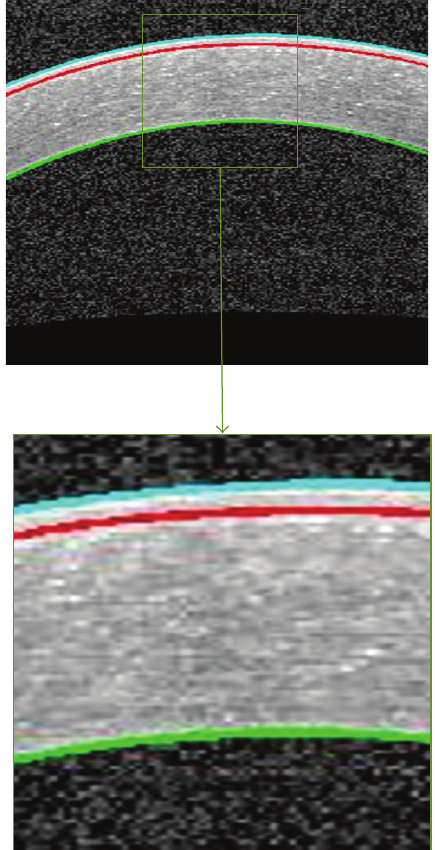
Figure 2: An example of segmented corneal image. The Epithelium boundary (cyan), the Bowman boundary (red), and the Endothe- lium boundary (green).